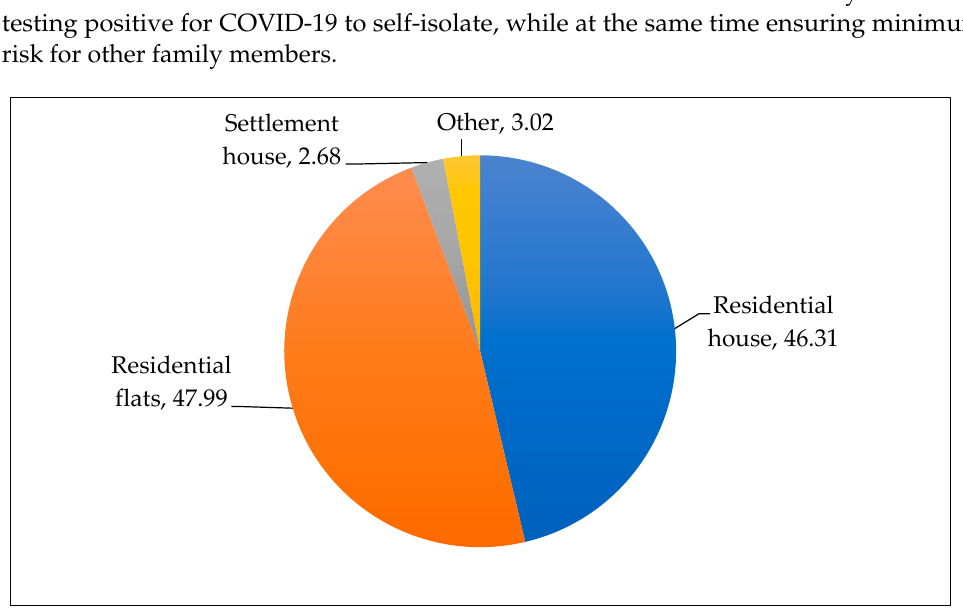
Figure 5. Types of accommodation reported by the respondents.